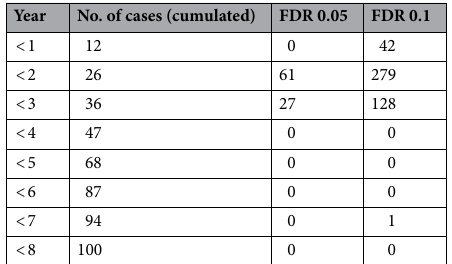
Table 5. Number of significant genes identified in analyses of metastatic cases according to years between blood sampling and diagnosis.